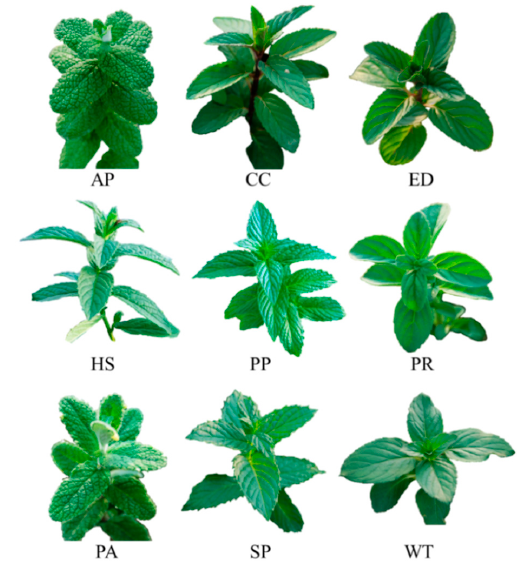
Figure 1. Nine Mentha species. AP, apple mint; CC, chocolate mint; ED, eau de cologne mint; HS, horse mint; PP, peppermint; PR, pennyroyal mint; PA, pineapple mint; SP, spearmint; WT, water mint.